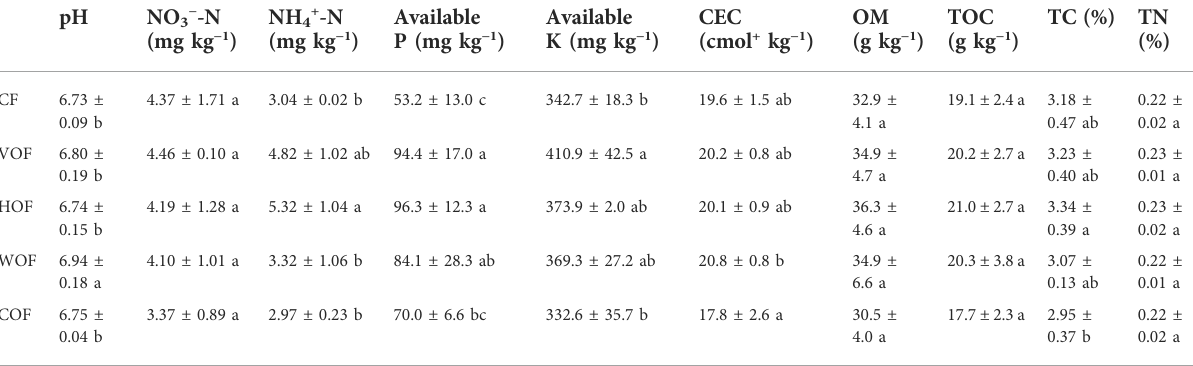
TABLE 2 Soil physicochemical properties when sampling tobacco (mean ± SD). CF, VOF, HOF, WOF, and COF represent the treatments of tobacco- special chemical fertilizer, vermicompost-based, humic acid-based, wood biochar-based, and compound functional organic fertilizers, respectively. Different letters within each column show a signi fi cant difference in soil physicochemical properties based on Duncan ’ s method ( p <